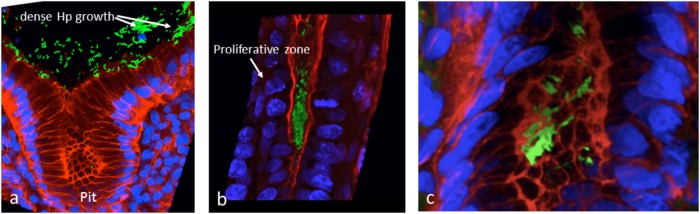
In vivo evidences suggestive of biofilm formation by H. pylori in the gastric glands of humans. (a) Large aggregates of H. pylori colonizing the surface of gastric glands; (b)
H. pylori aggregates colonizing the neck of gastric glands, with proliferative cells; (c) colonies of H. pylori deep in the gland, in the vicinity of stem cells. H. pylori in green, actin in red and DNA nucleus in blue.